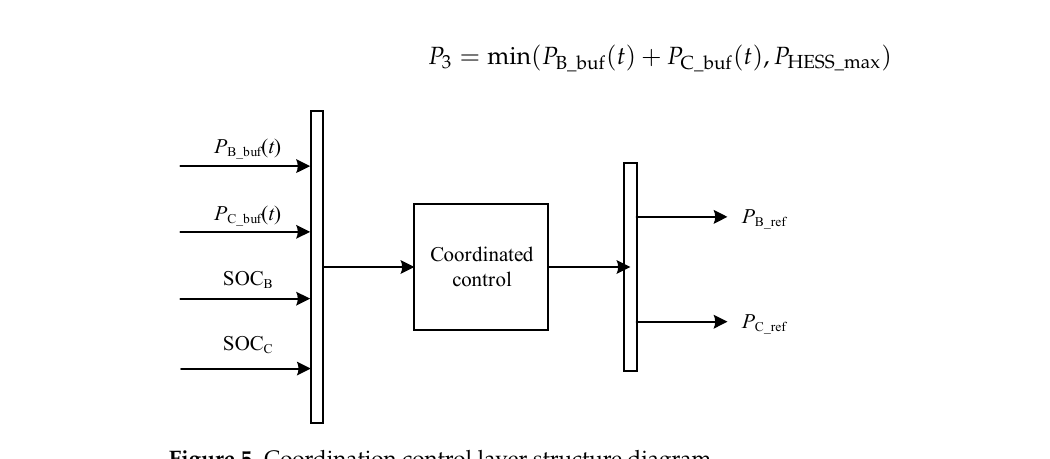
Figure 5. Coordination control layer structure diagram.